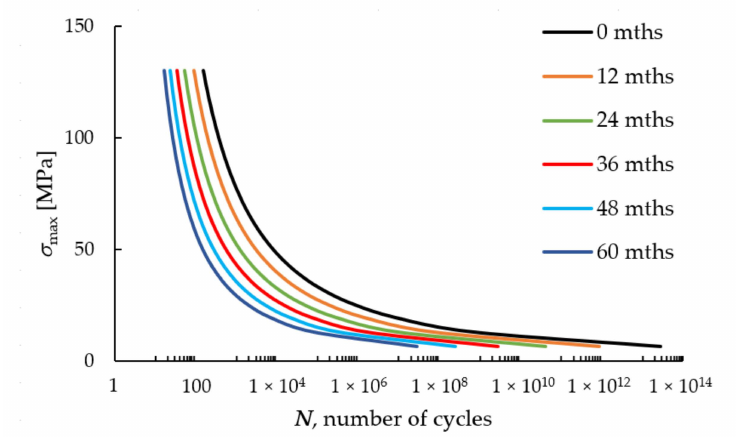
Figure 5. S–N curve change, (0/90)s polyester/glass composite.